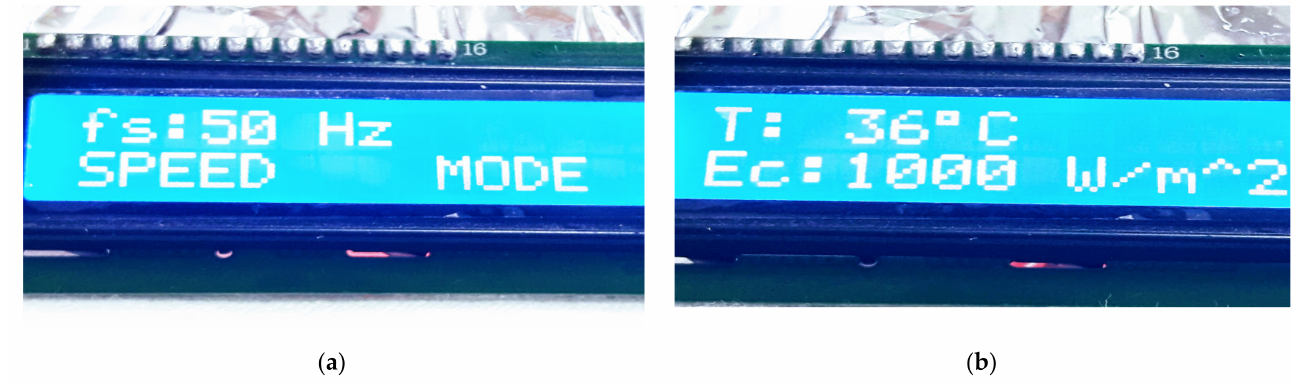
Figure 26. ( a ) Temperature and irradiation visualization; ( b ) frequency visualization. The photos below were taken while displaying the temperature, sunshine value, frequency occurred, and pump speed mode with a delay of 3 s for each display.